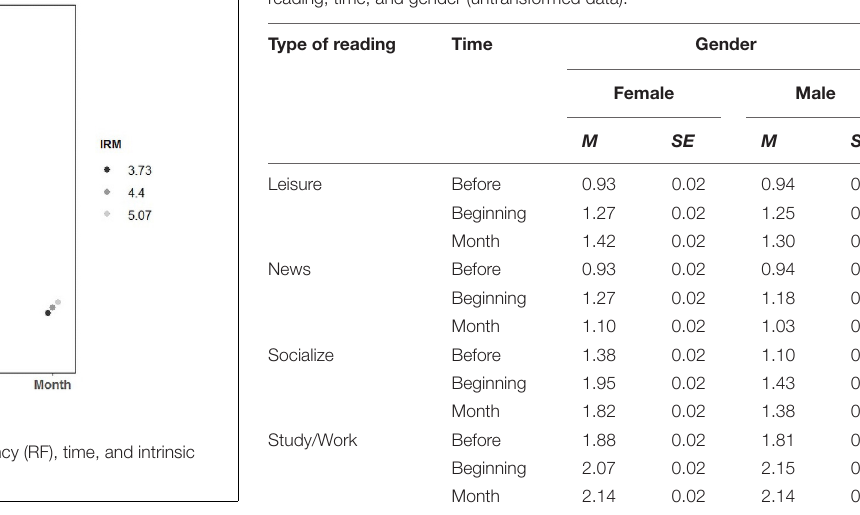
TABLE 3 | Means and SE of reading frequency (hours per day) per type of reading, time, and gender (untransformed